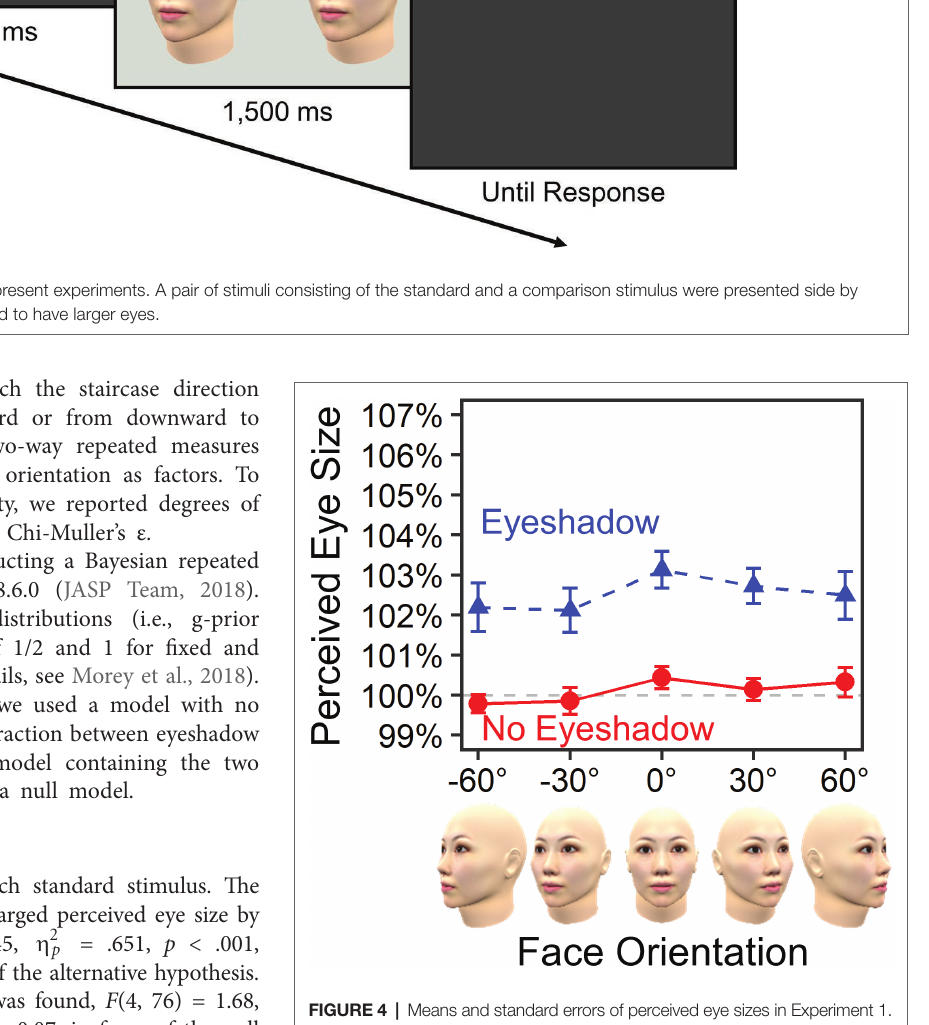
FIGURE 4 | Means and standard errors of perceived eye sizes in Experiment